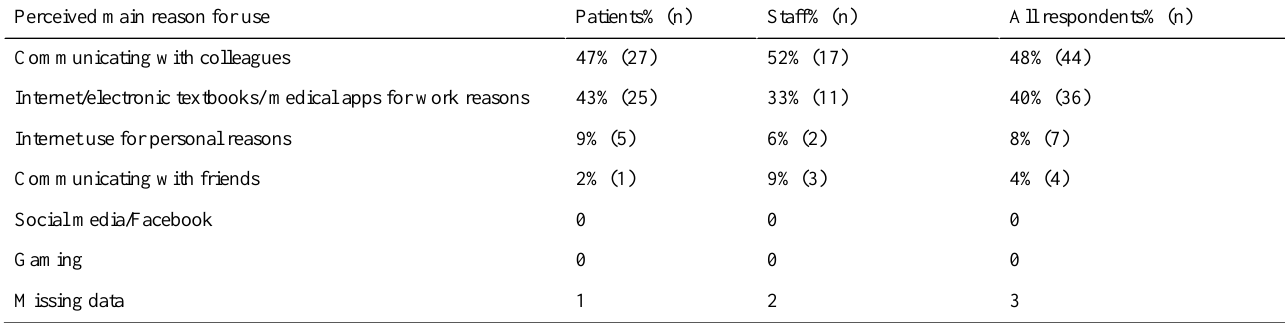
Table 2. Patients’and staff members’suspected main reason for mobile device use in the workplace.